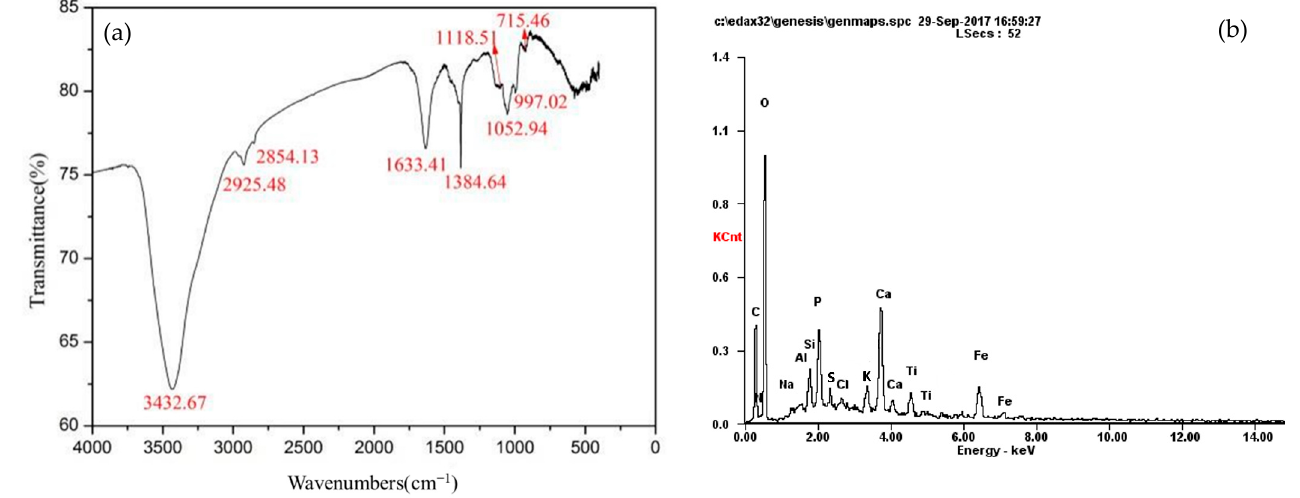
Figure 10. ( a ) FTIR spectra of foulants; ( b ) EDX spectra of foulants.